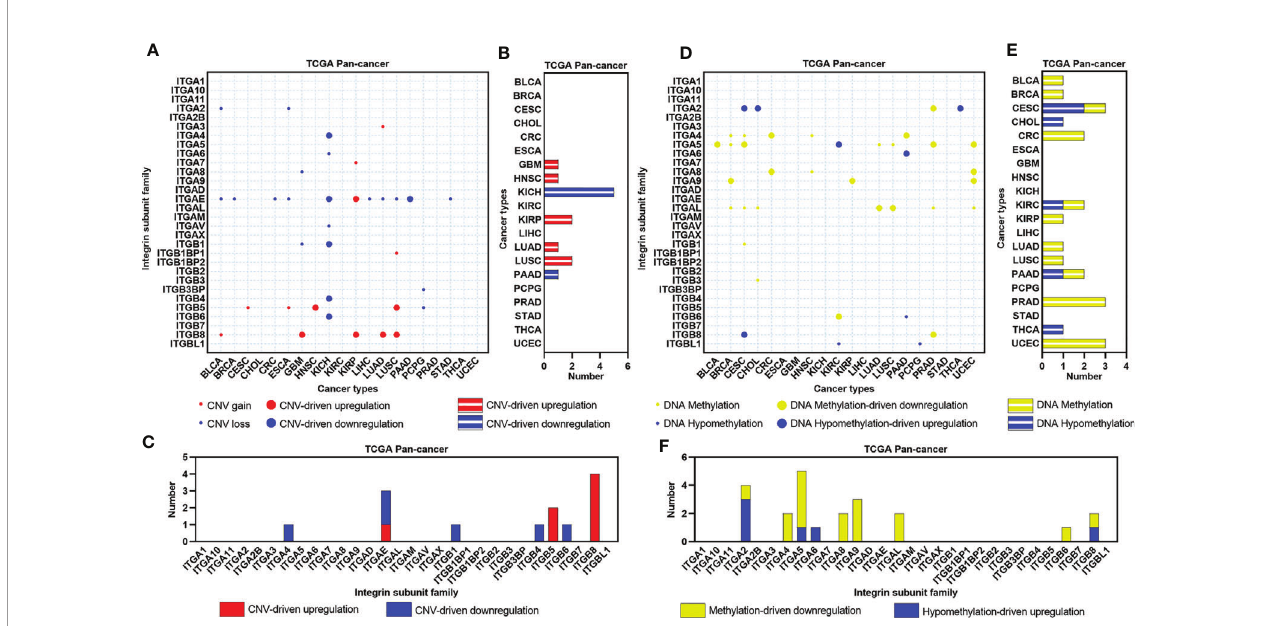
FIGURE 2 | CNV and DNA methylation landscapes of ITGs in human cancers. (A) Heatmap showing the CNV types of ITGs across multiple cancers from the TCGA. (B) Barplot showing the number of CNV-driven dysregulated ITGs for each cancer from the TCGA. (C) Barplot showing the distribution of CNV-driven dysregulated ITGs across multiple cancers from the TCGA. (D – F) Similar to (A – C) , but for DNA methylation types and Methylation/Hypomethylation-driven dysregulated